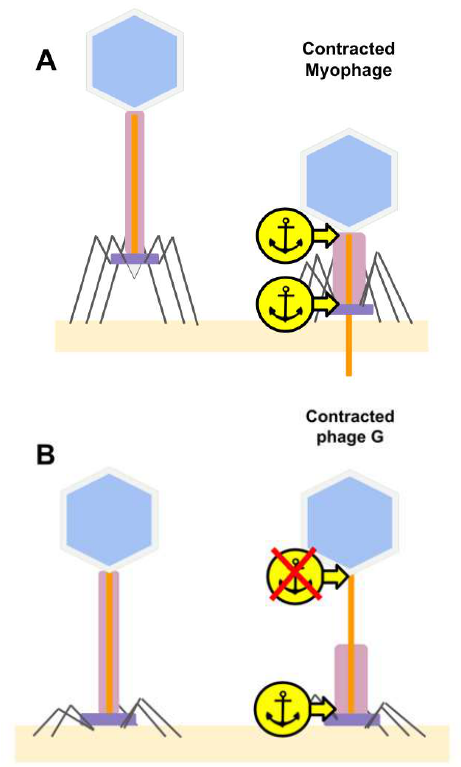
Figure 11. Tail sheath anchor points in a typical myophage and phage G during contraction. ( A ) In the typical myophage tail sheath contraction [5,58], the tail sheath stays in contact with the neck region via the upper of two initial anchor points. ( B ) In the atypical tail contraction of phage G, the upper anchor point appears to be missing and the contracted sheath is positioned at the tail tip (See Figure 1A).